Question: Sum up the contents of this chart in one sentence.
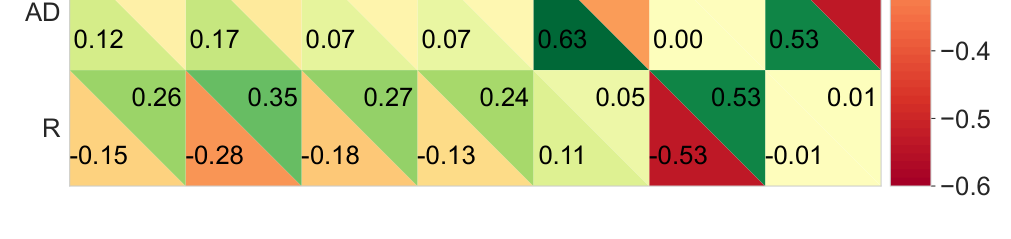
Answer: Average rewards after evaluating 10 fully trained LOQA and POLA seeds against different agents in a 3x3 sized Coin Game. We abbreviate L:LOQA, L-R:LOQA without replay buffer, L- S:for LOQA without self-play, P:POLA, AC:Always Cooperate, AD:Always defect and R:Random.